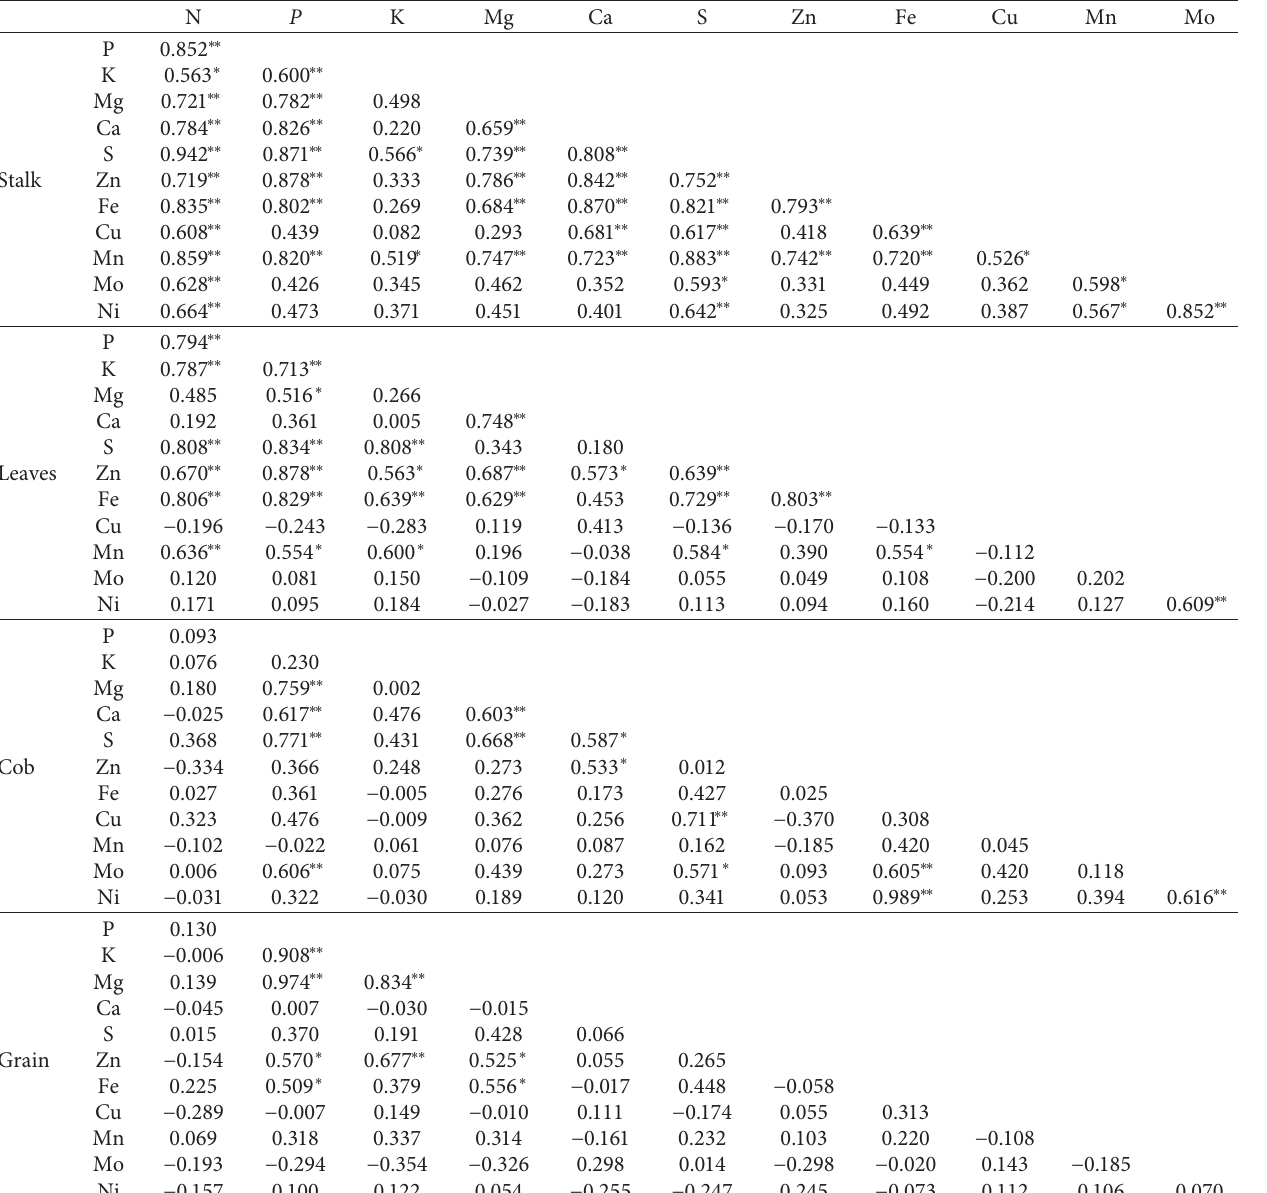
Table 3: Correlation analysis between